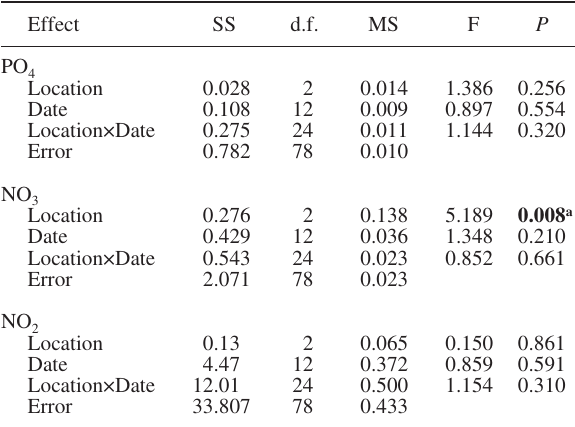
Table 1. – Results of the two-way ANOVA for comparing nutrient concentrations among study locations and sampling dates. Bold: significant P values.